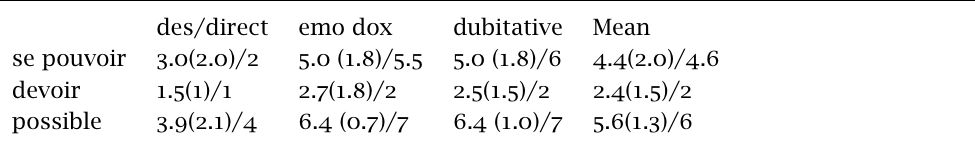
Descriptive statistics for French follow-up survey with se pou- voir in place of pouvoir , of the form mean (standard devia- tion)/median.